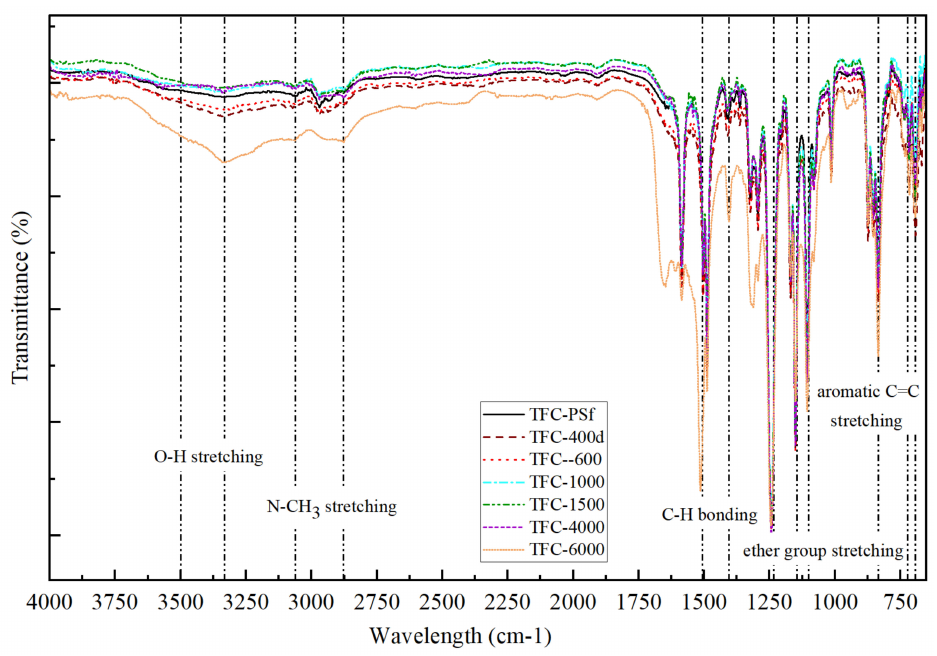
Figure 6. FTIR spectra of the pristine TFC-PSf membrane and modified TFC membranes with different M w of PEG.